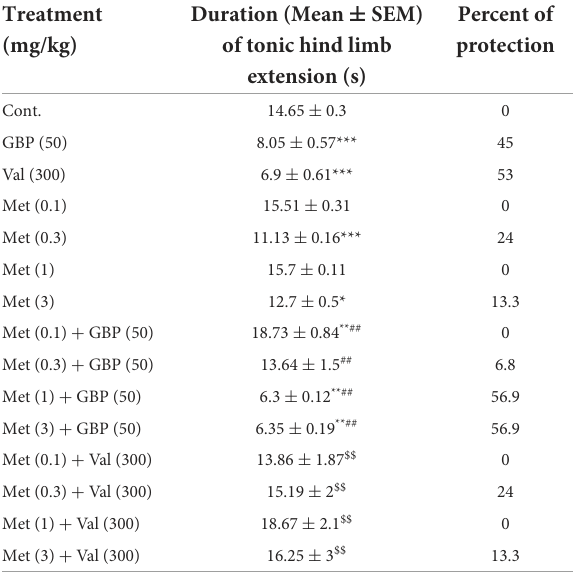
TABLE 1 Effect of methadone, gabapentin, and sodium valproate, and their combination pretreatment on MES-induced seizures in